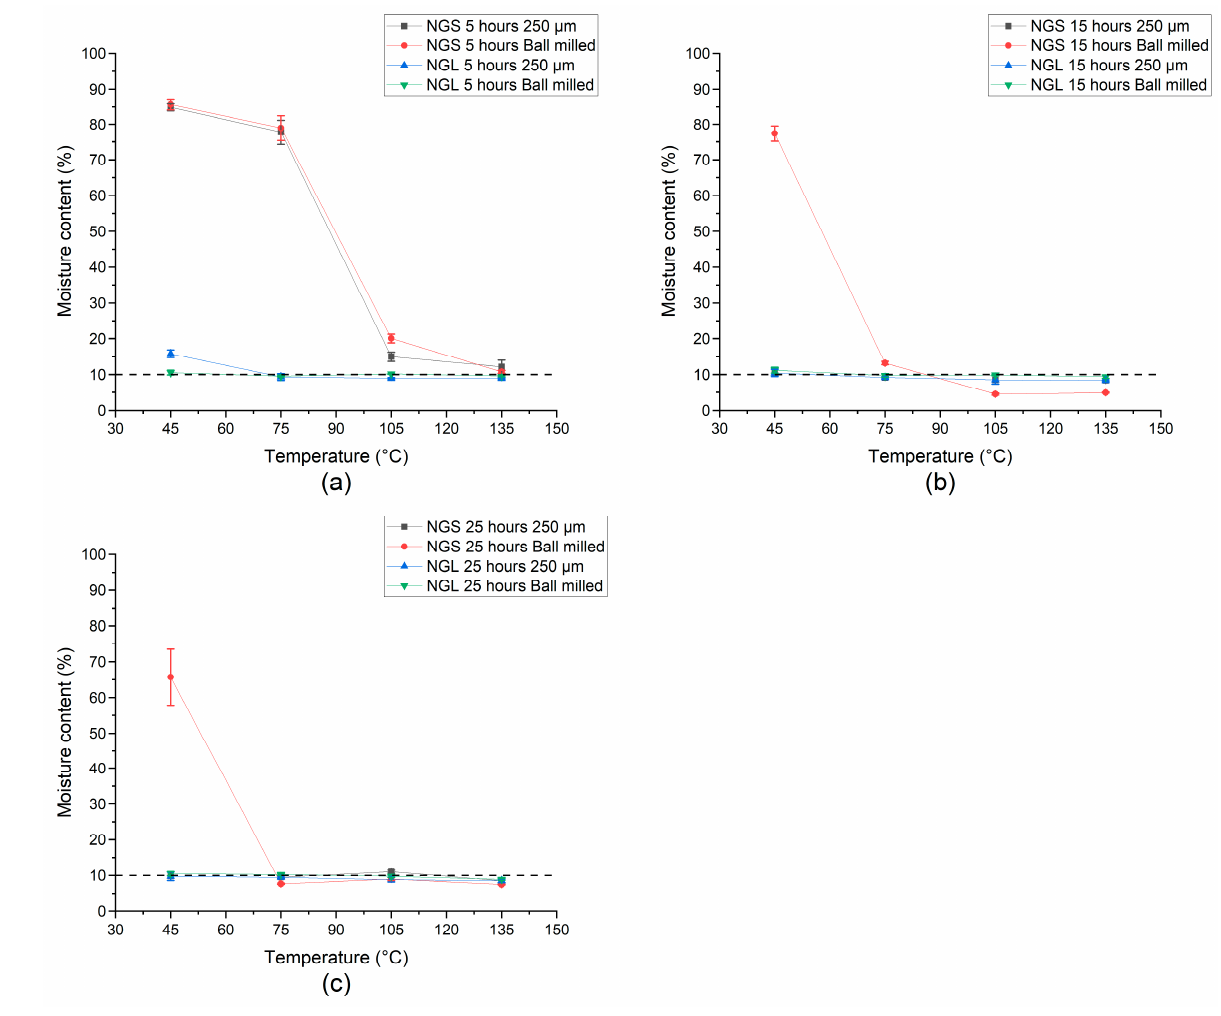
Figure 1. Moisture content against temperature ( a ) 5 h, ( b ) 15 h and ( c ) 25 h.